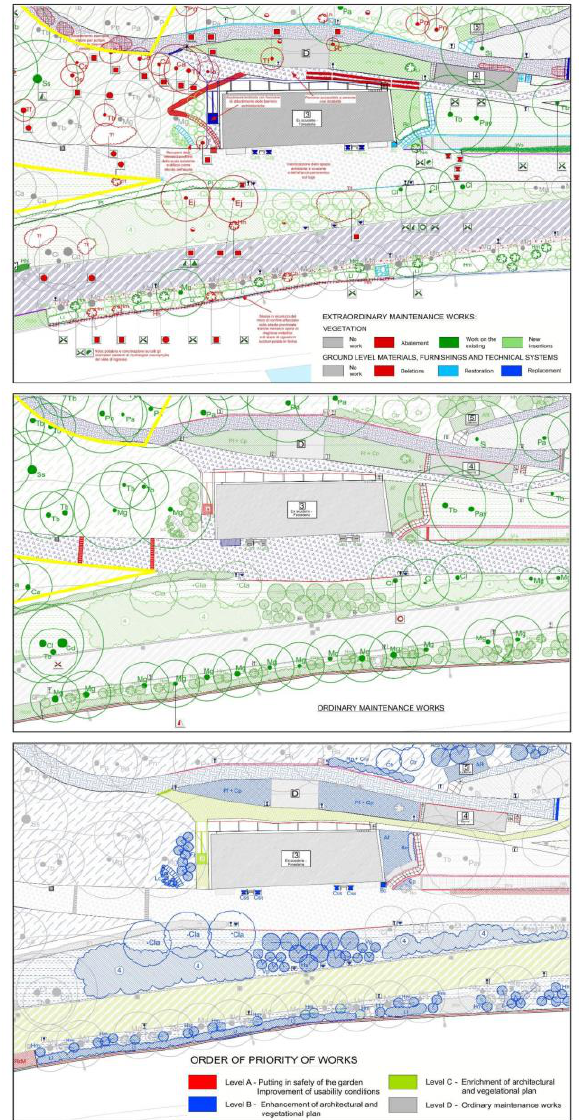
Figure 5. Extraordinary and ordinary maintenance works, and order of priority of works, on the former stables area of the Villa del Grumello historic garden on Como Lake.